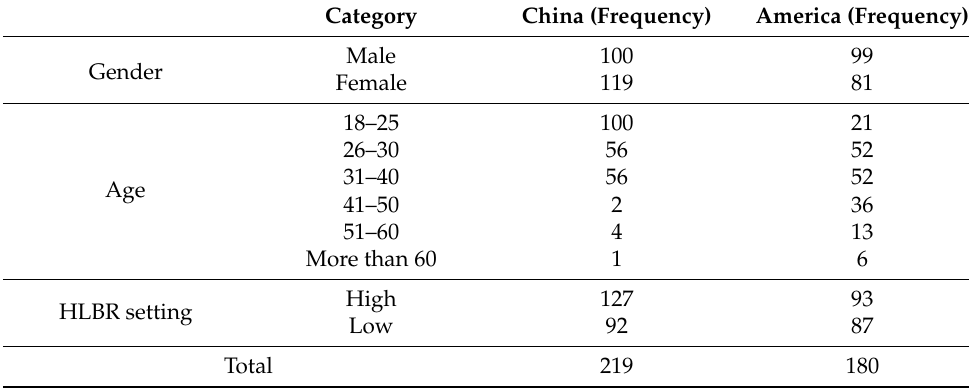
Table 1. Descriptive statistics for the